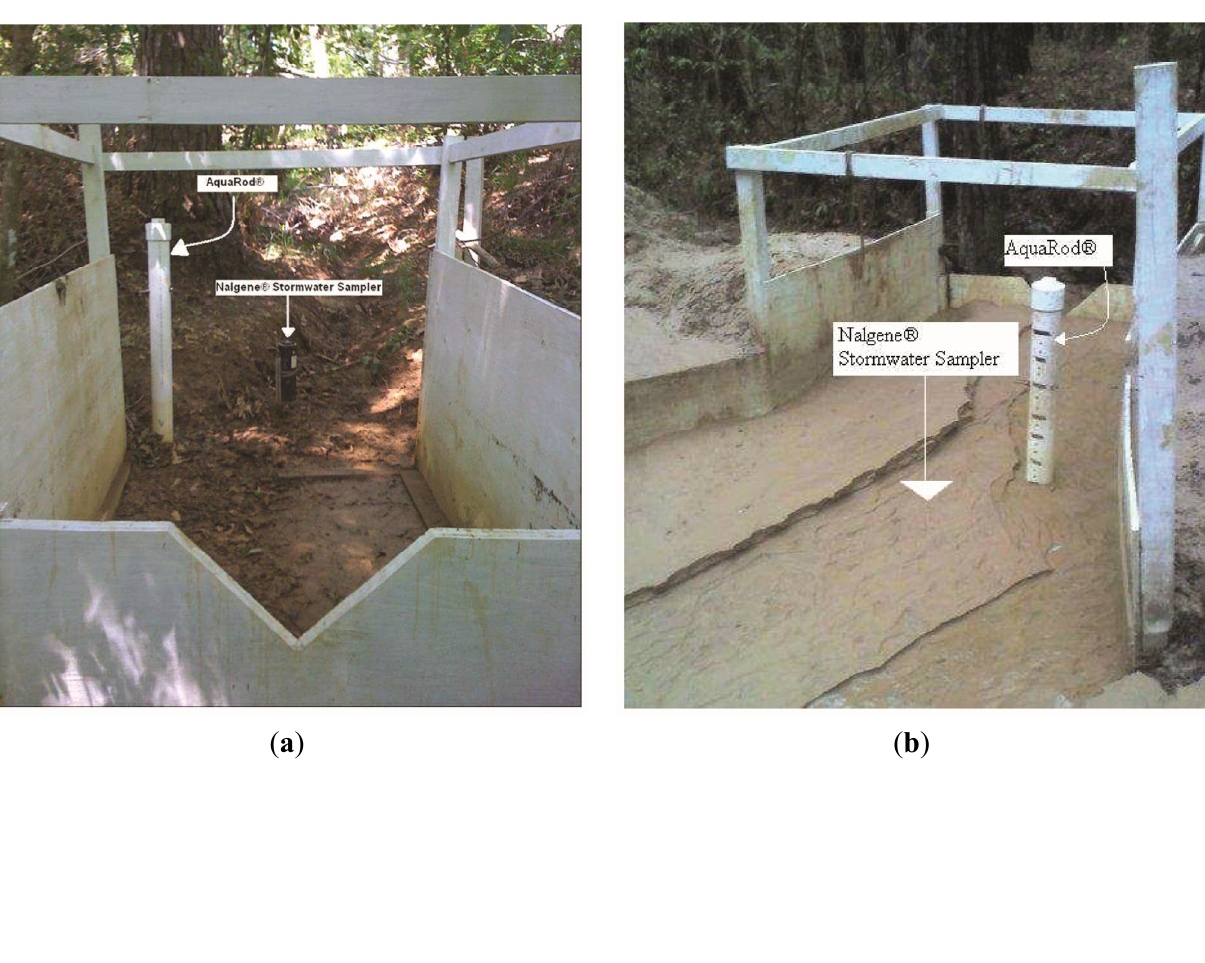
Figure 3. In-channel instrumentation for measuring total runoff (V-notch weir), stream level (Aquarod ® ), water quality (Nalgene ® Stormwater Sampler), and sediment (drop box) on the F2 sub-watershed before a storm event ( a ) and after a 6.3 cm rain event in April, 2009 at F1 ( b ); at the Alto Experimental Watersheds in Texas,